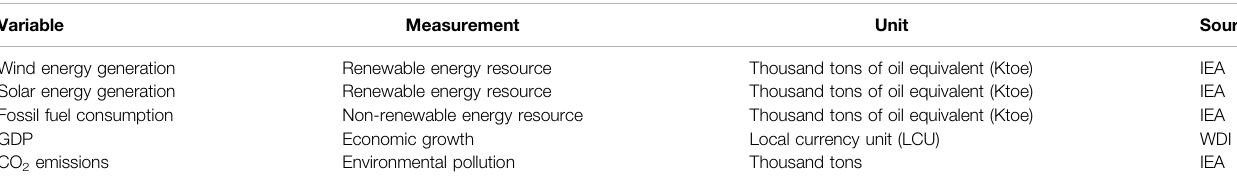
TABLE 1 | Description of the study